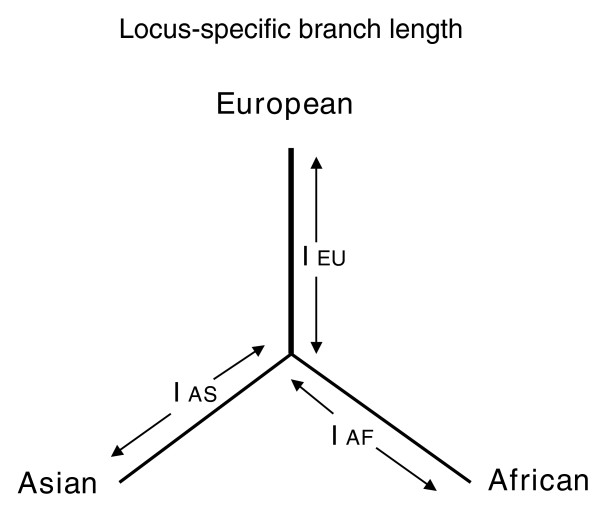
Schematic illustrating the use of pairwise FST scores to generate a locus-specific branch length (as described in [18]). Branch lengths (lEU, lAF, lAS) were calculated from single locus pairwise FST distances. lEU = (European:Asian FST + European-African FST - Asian-African FST)/2; lAS = (European-Asian FST + Asian-African FST - European-African FST)/2; lAF = (European-African FST + Asian-African FST - European-Asian FST)/2.